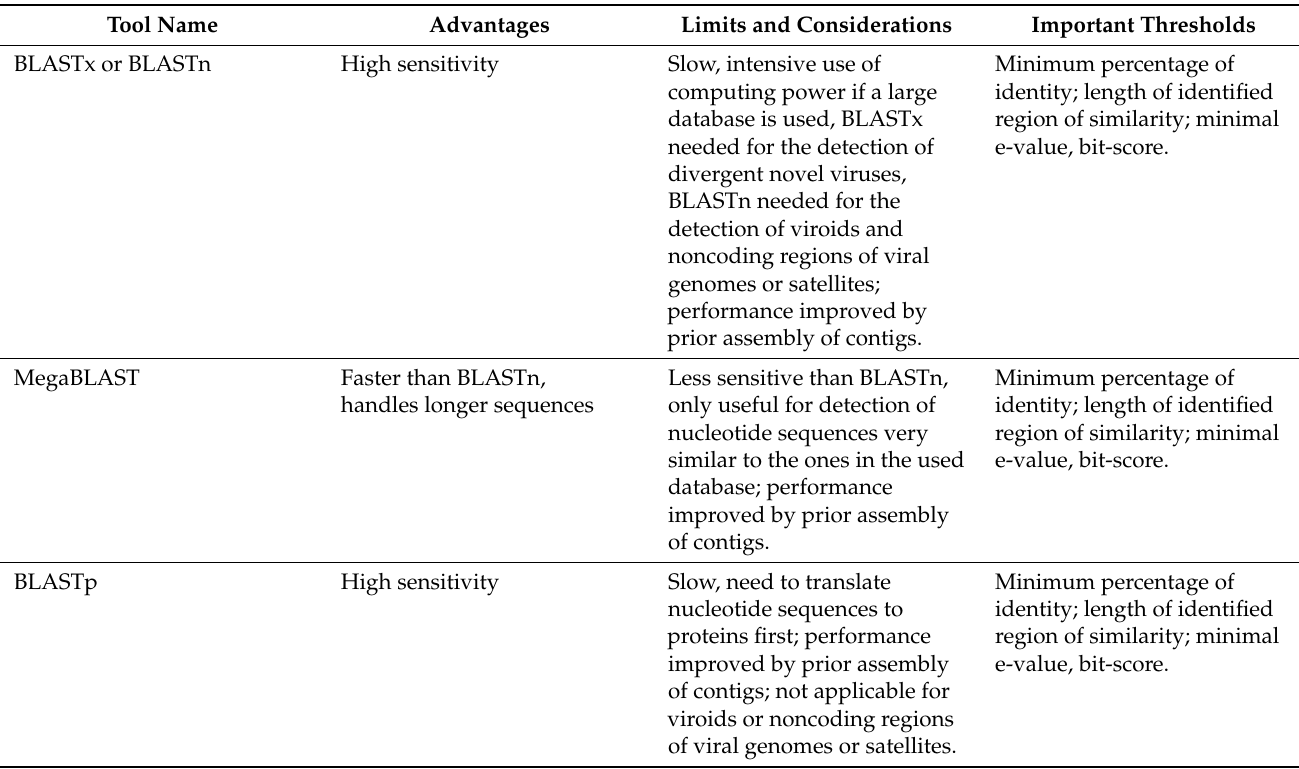
Table 1. Summary of the most commonly used similarity search strategies with advantages and limitations for each of the